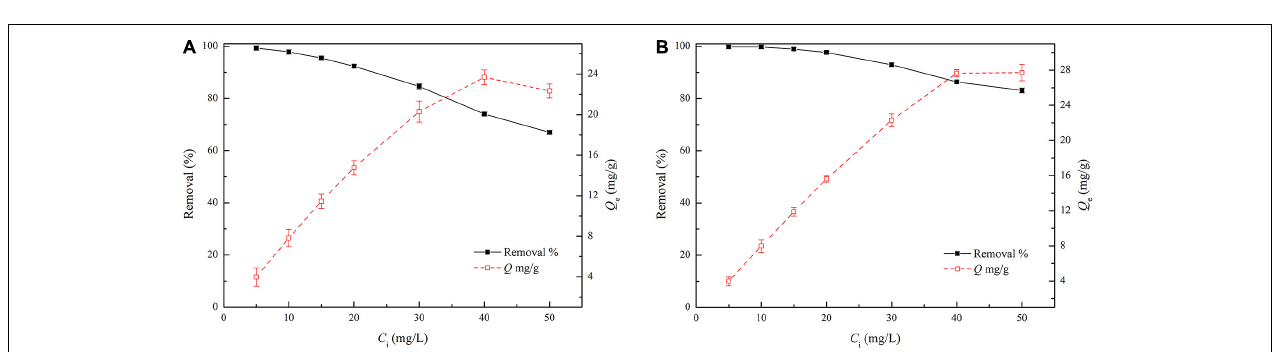
FIGURE 3 | The effect of the initial TC concentration on the adsorption capacity and removal percentage. (A) PBC and (B) TPBC.